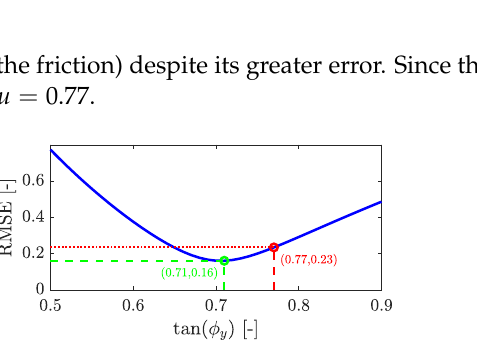
Figure 8. Optimisation of the parameter µ = tan ( φ y ) . The smallest RMSE is resolved for µ = 0.71, whereas the physical value µ = 0.77, derived from laboratory measurements, is similar in magnitude. However, such an RMSE value is still greater than the one obtained by robust power-law fitting.